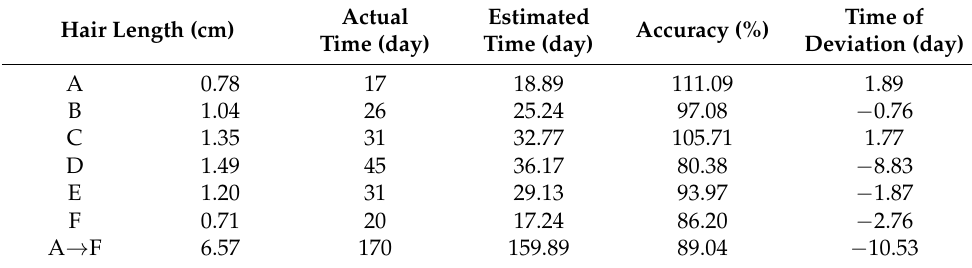
Table 3. Estimation results for patient No.